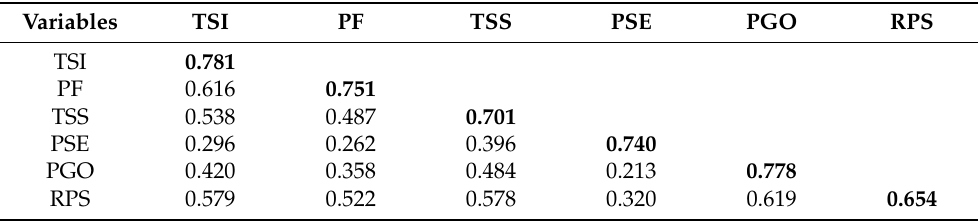
Table 3. The discriminant validity of the measurement model. Bold limbs are the average variance extracted